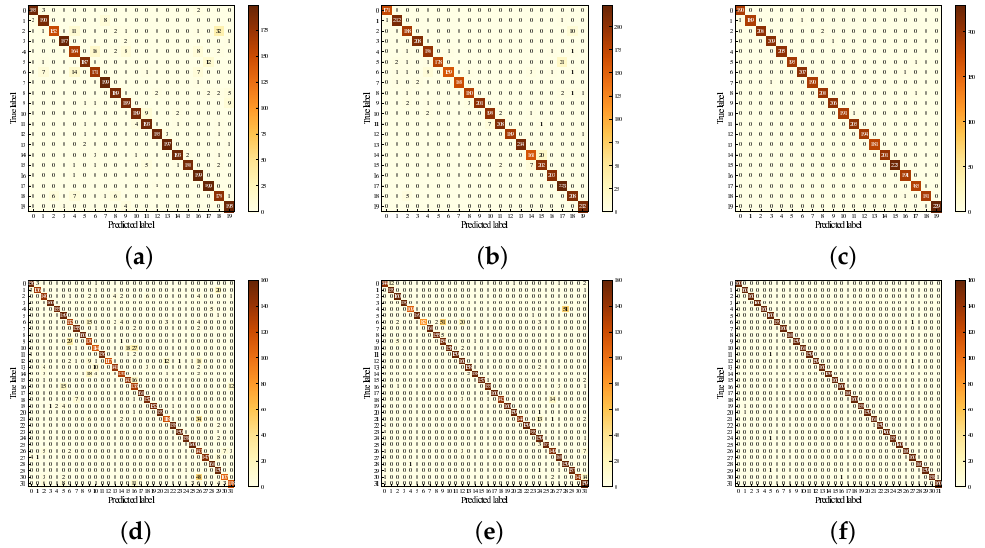
Figure 10. Confusion matrices by three different methods for the two datasets, ( a ) MRFGCN for SEU, ( b ) MRFGCN for SEU, ( c ) AE-MSGCN for SEU, ( d ) GCN for CMO, ( e ) MRFGCN for CMO, ( f ) AE-MSGCN for CMO.